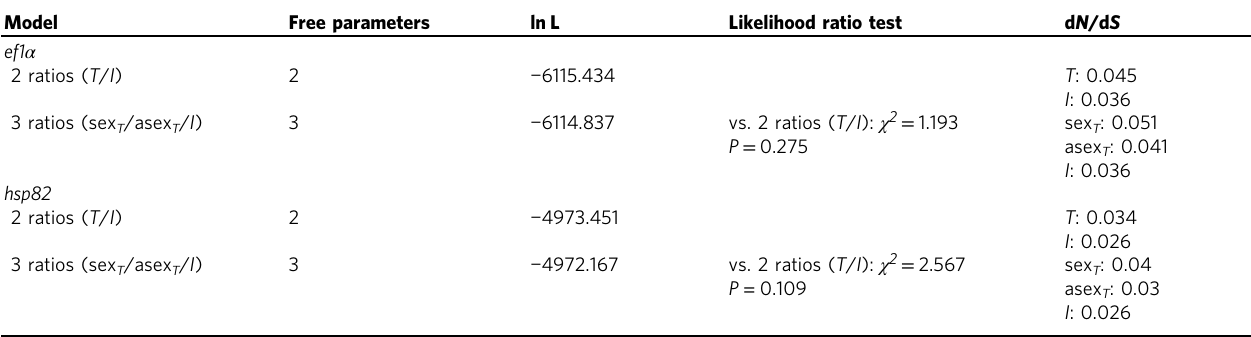
asex T terminal asexual branches, I internal branches, ln L ln(Likelihood), sex T terminal sexual branches, T terminal branches Non-signi fi cant P values indicate that the two-ratio model provides the better fi t to the data than the three-ratio model for both genes. Therefore, asexual and sexual branches did not differ in the effectiveness of selection on nonsynonymous sites in these two genes